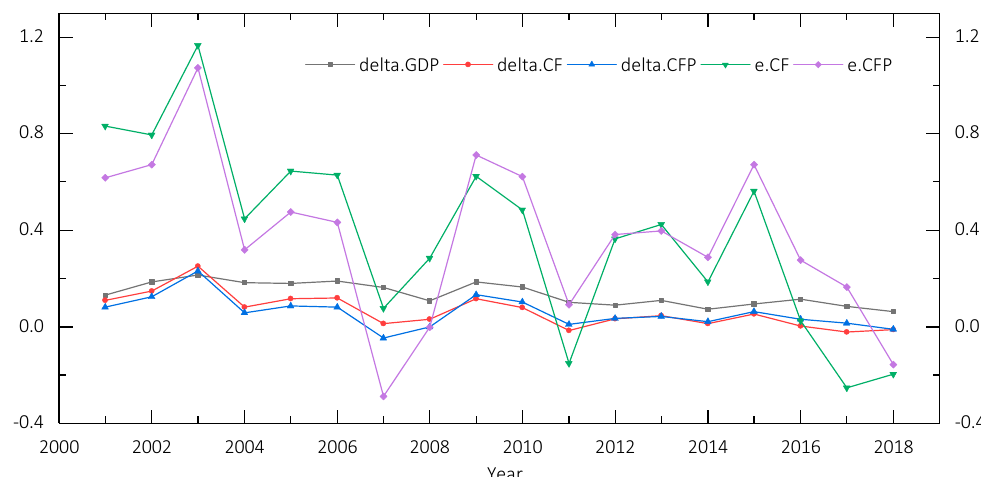
Figure 4. The change rate of GDP and CO 2 , as well as the elasticity change of the carbon footprint and carbon footprint pressure of fossil energy consumption.